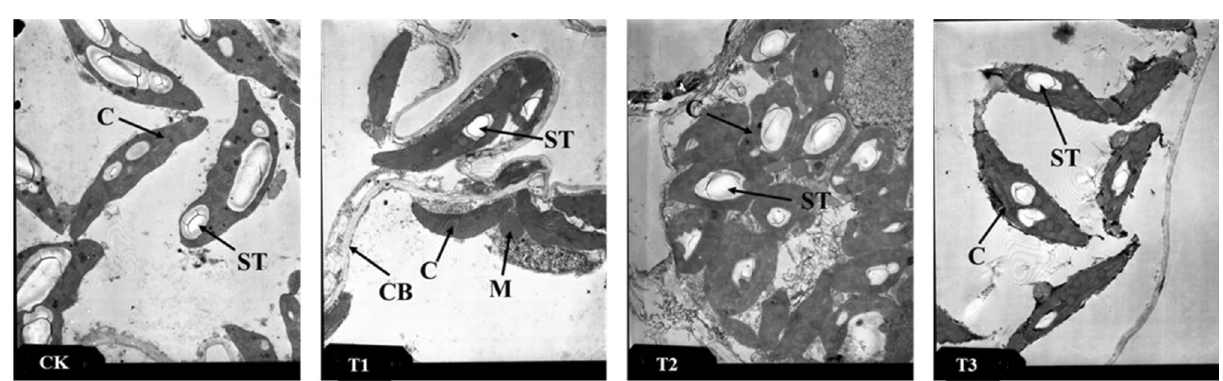
Figure 10. TEMs of Phedimus aizoon L. leaves under drought stress (× 5000). C, chloroplast; ST, starch grain; M, mitochondrion; CB,